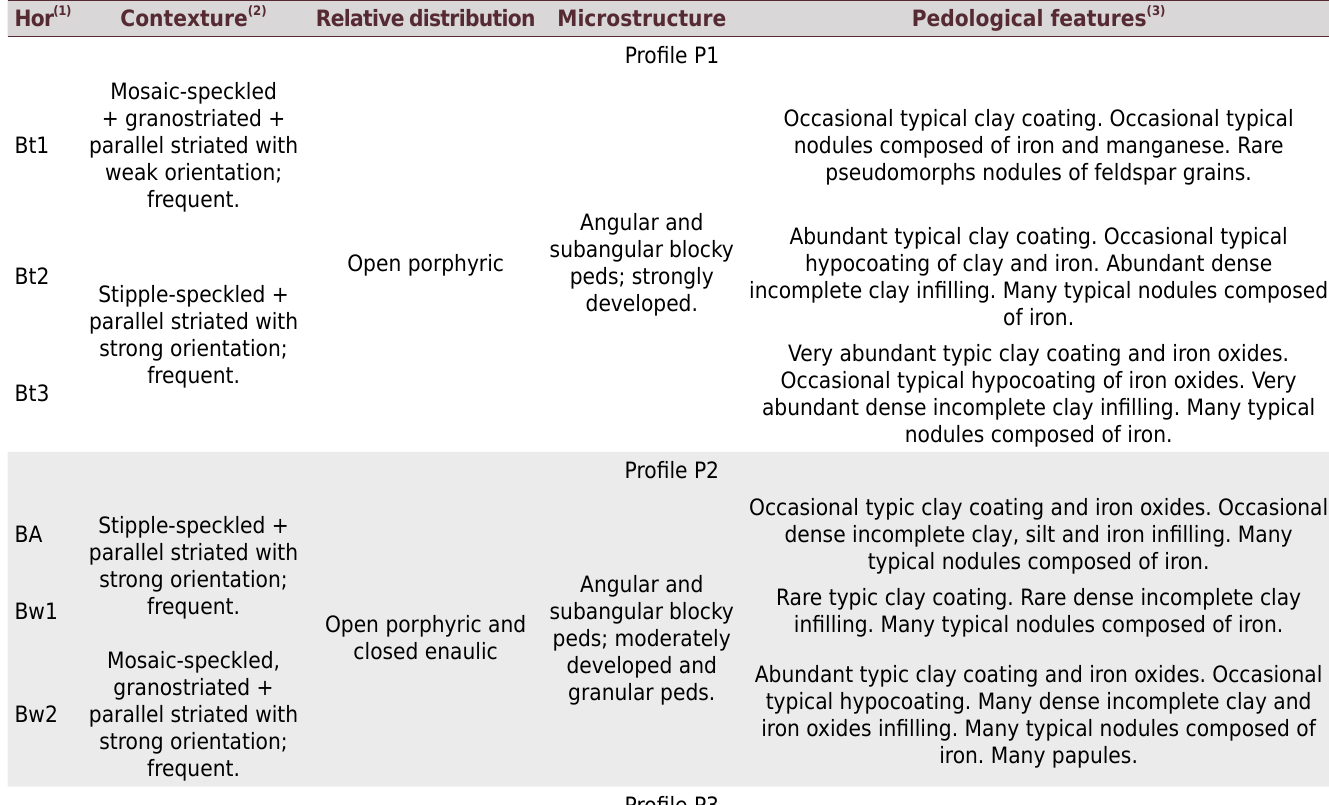
Table 6. Micromorphological description of selected soil horizons in the Rio de Janeiro State, Southeastern